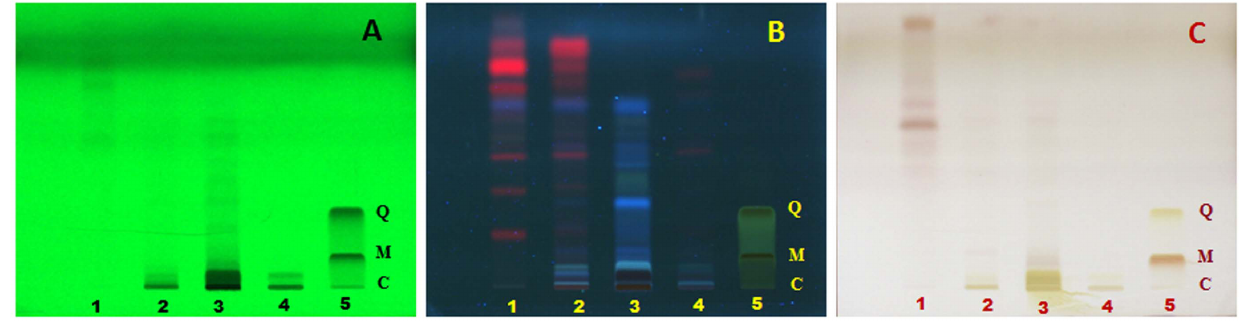
Figure 8. HPTLC fingerprint of extracts of G.glauca leaf. (1) Petroleum ether extract, (2) Ethyl acetate extract, (3) Methanol extract, (4) Ethanol extract (70% v/v) at (A) 254 nm, (B) 366 nm and (C) 600 nm. Standards used are quercetin (Q), myricetin (M) and catechin (C) in lane 5.